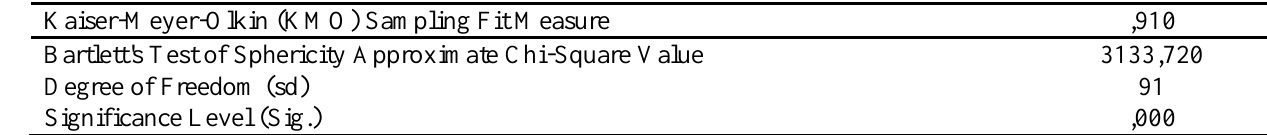
Table 2. KMO and Bartlett's test statistics regarding the scale of importance given to rewards / services